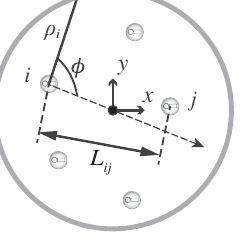
FIG. 12. Schematic diagram of the pole-pole interaction and the pole-cortex interaction in a round cell. Note that L ij is the distance between any two poles, and ρ i is the distance from the i th pole to the cortex in the ϕ direction.